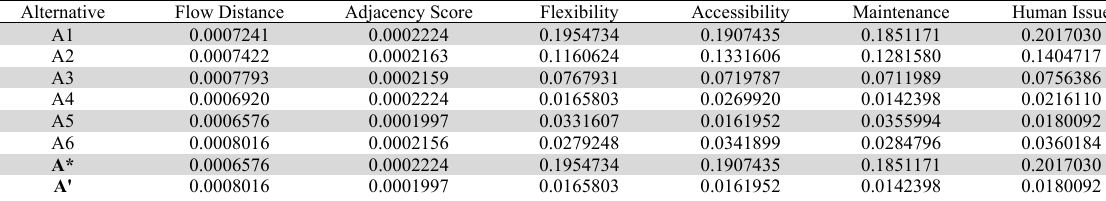
Weighted normalized decision matrix with positive and negative ideal solution Alternative Flow Distance Adjacency Score Flexibility